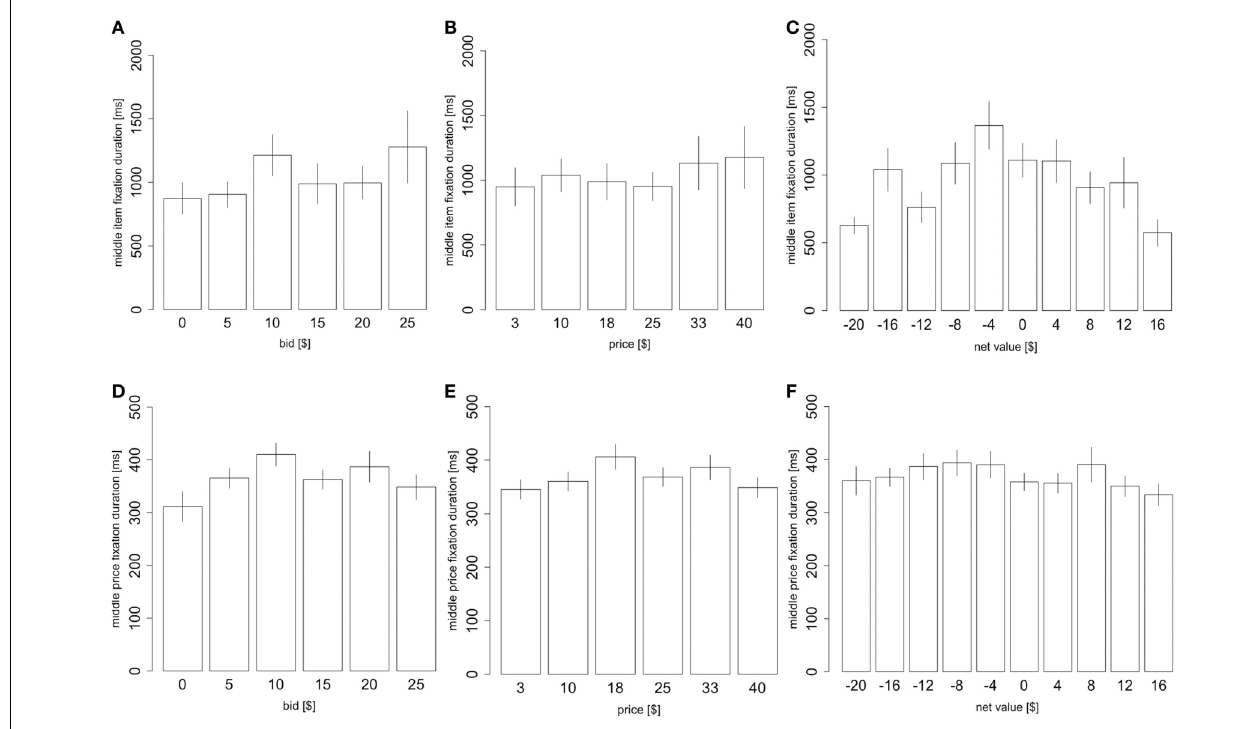
FIGURE 6 | Fixation properties. (A) The duration of middle item fixations as a function of the item value, (B) price, and (C) net value. (D) The duration of